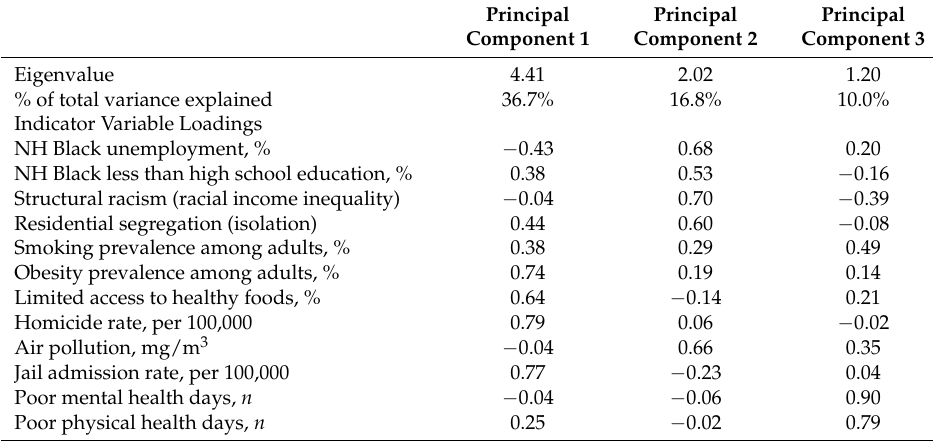
Table 4. Principal component analysis of Black IMR social determinant indicators in 100